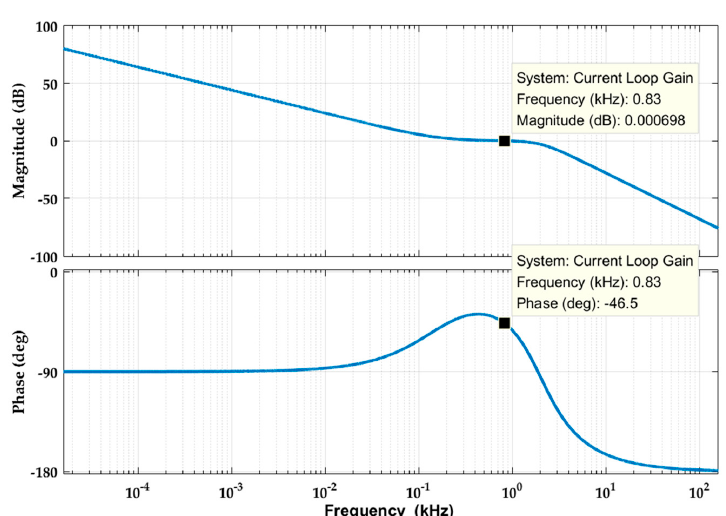
Figure 11. Bode plot of the current control loop gain.